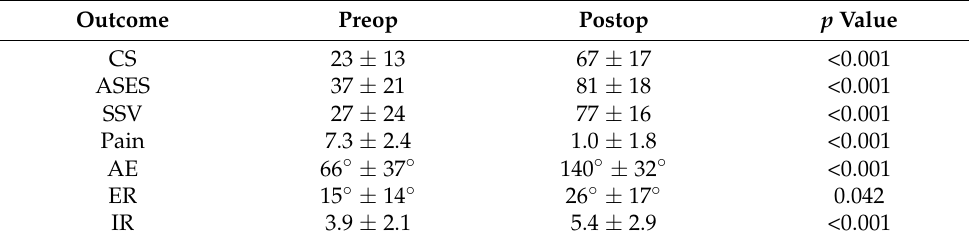
CS, Constant Score; ASES, American Shoulder and Elbow Surgeon; SSV, Subjective shoulder value; AE; anterior elevation; ER, external rotation; IR, internal